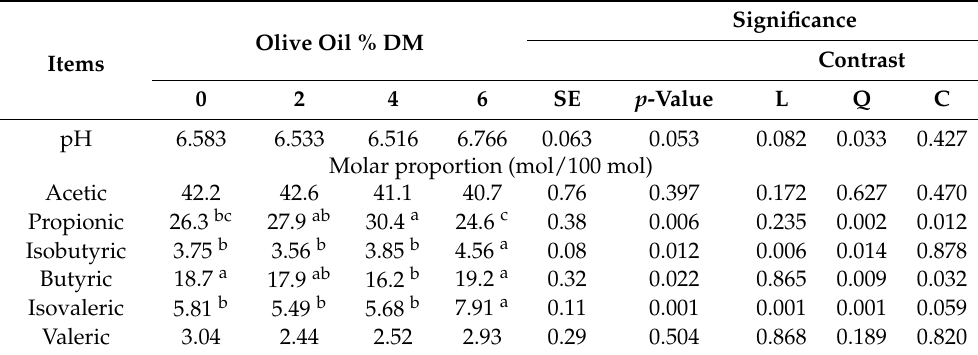
Table 4. Effect of the inclusion of olive oil on rumen fluid pH and molar proportion of volatile fatty